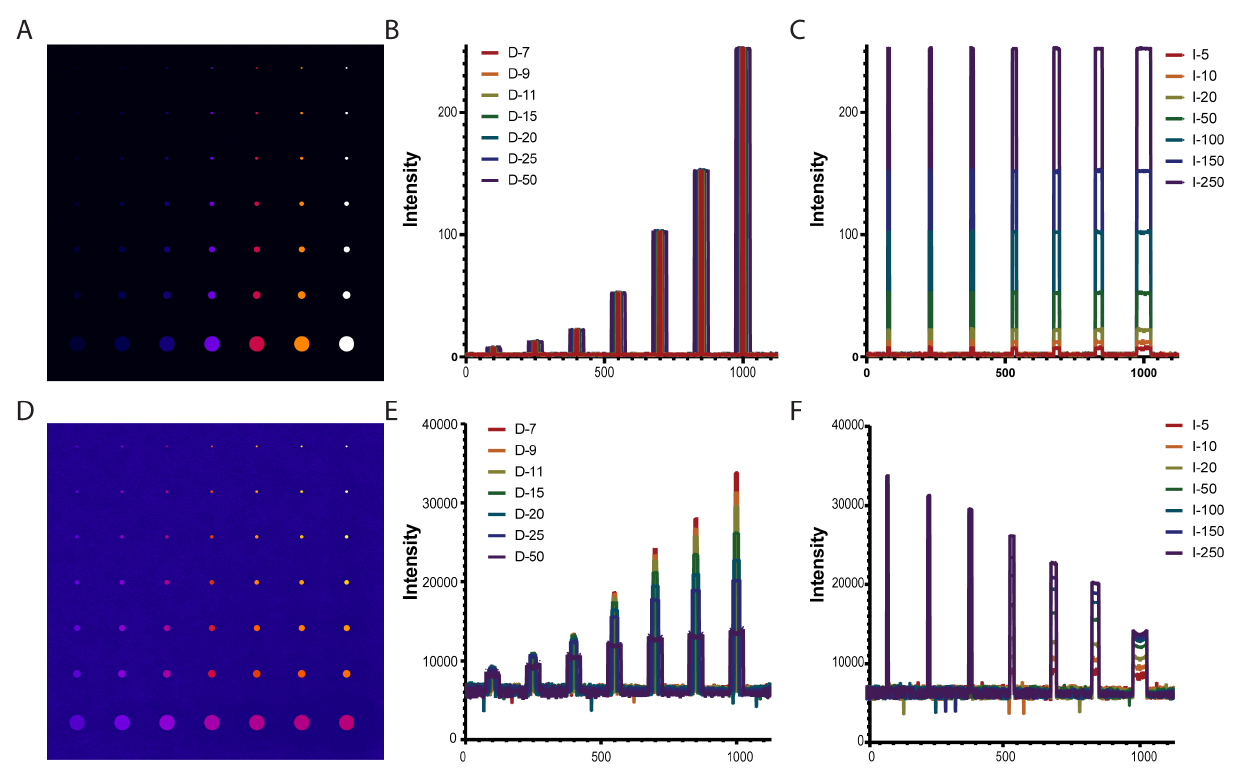
Figure 3. Synthetic images to illustrate the effect of DEVILS. ( A ) Synthetic image of disks with increasing pixel intensity values from left to right (5, 10, 20, 50, 100, 150, 250) and of increasing diameter from top to bottom (7 px, 9 px, 11 px, 15 px, 20 px, 25 px, 50 px). Display settings are set to the minimum and maximum intensity values of the image and the “Fire” LUT is used for display. ( B ) Vertical line profiles over disks shown in A . The different diameters are labelled with different colours. ( C ) Horizontal line profiles over disks shown in A . the different intensities are labelled with different colours. ( D ) Image A processed with the DEVILS plugin ( p = 25). ( E ) Vertical line profiles over disks shown in D . The different diameters are labelled with different colours. ( F ) Horizontal line profiles over disks shown in D . the different intensities are labelled with different